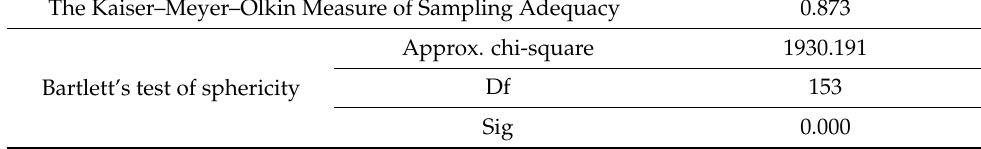
Table 3. KMO and Bartlett’s test.